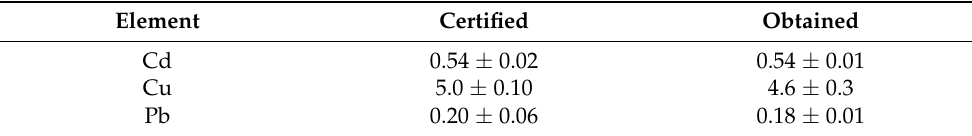
Table 2. Comparison of the atomic absorption spectrometry (AAS)-obtained heavy metal